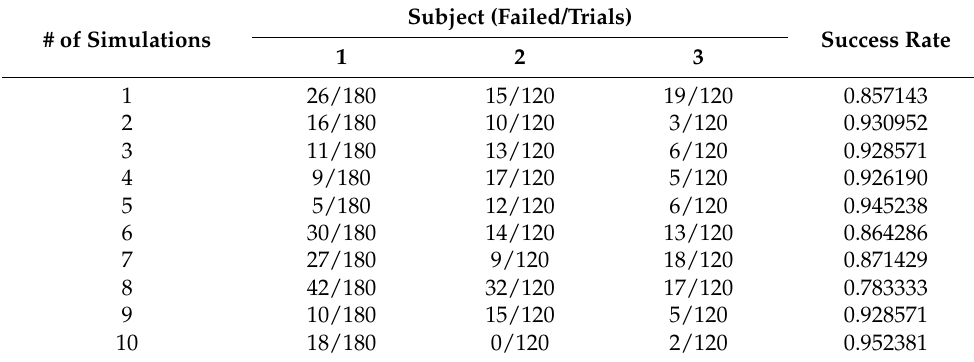
Table 3. Accuracy results of classification for 10 simulations, with changing random seeds uniformly in